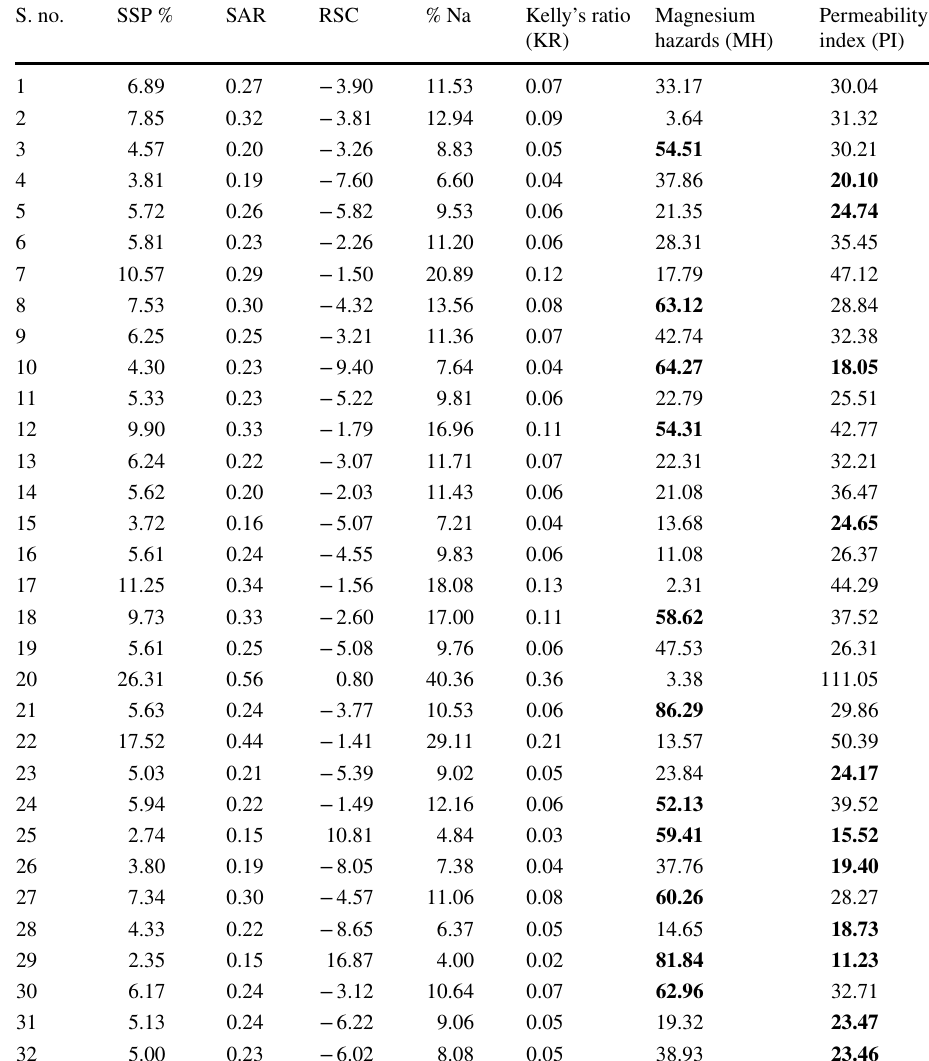
Bold values are representing the ‘higher concentration’ of the